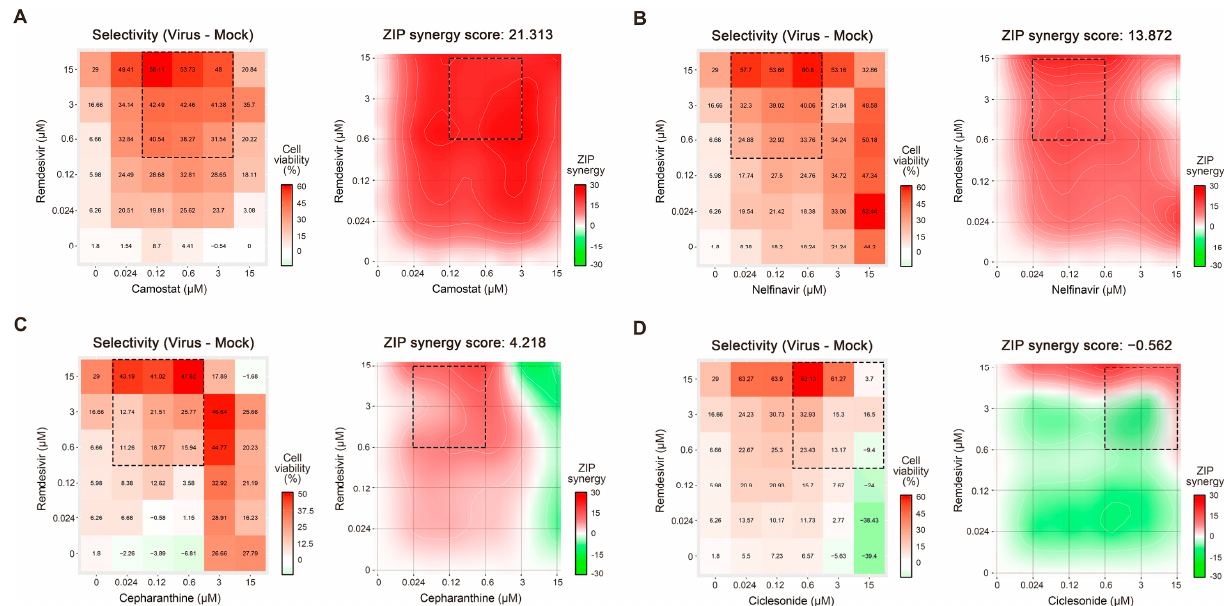
Figure 3. Evaluation of drug combinations in severe acute respiratory syndrome coronavirus 2 (SARS-CoV-2)-infected Vero-E6 cells. As a read-out, virus-mediated cell death in the presence and absence of drugs was assessed. ( A ) Remdesivir– camostat; ( B ) remdesivir–nelfinavir; ( C ) remdesivir–cepharanthine; and ( D ) remdesivir–ciclesonide interactions were monitored. Dose–response matrices and synergy distribution maps are shown on the right and left panels with corresponding cell viability and zero interaction potency (ZIP) synergy, respectively. X and Y axes indicate drug concentrations ( µ M). ZIP synergy scores were calculated as described in the Material and Methods section. Table 1. ZIP synergy scores of drug combinations in SARS-CoV-2 infected Vero-E6 cells. Drug Combination Synergy Score